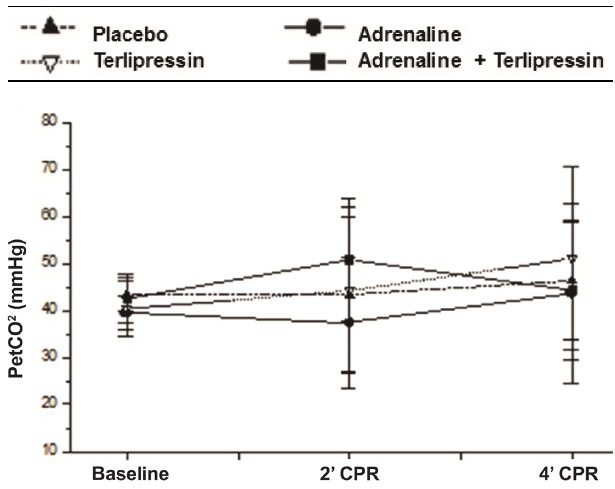
Fig. 1 – Comparative evolution of the variables assessed at baseline (0), 2 min of CPR (2) and 4 min of CPR in the groups studied. Average value and standard deviation of PetCO 2 in each moment and group.